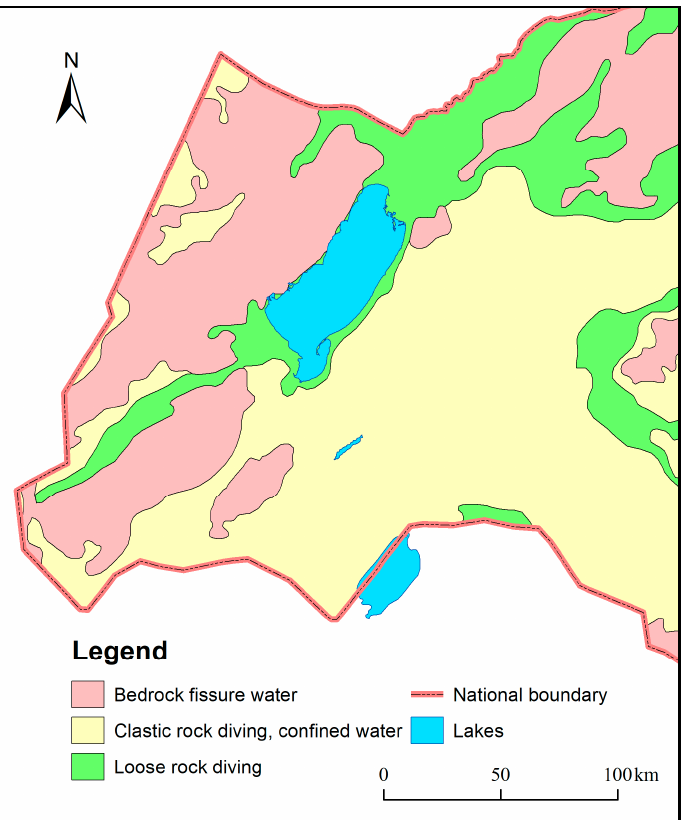
Figure 9. Zones of groundwater-occurrence conditions around Hulun Lake